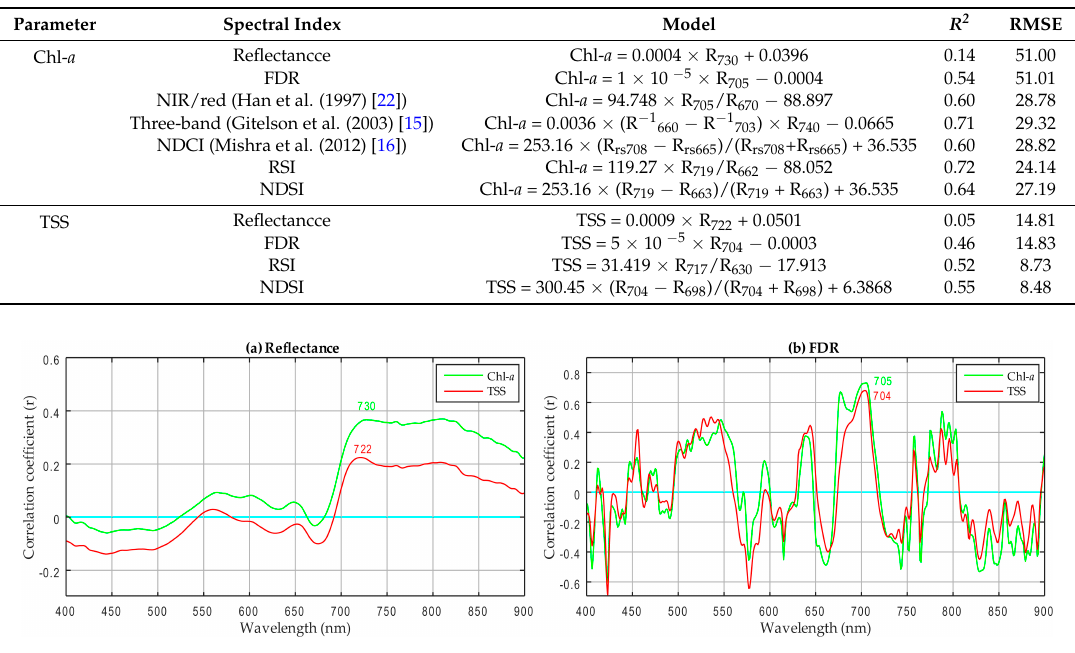
Figure 2. Correlation coefficients ( r ) between water quality parameters (Chl- a and TSS) at each wavelength: ( a ) reflectance; ( b ) FDR.